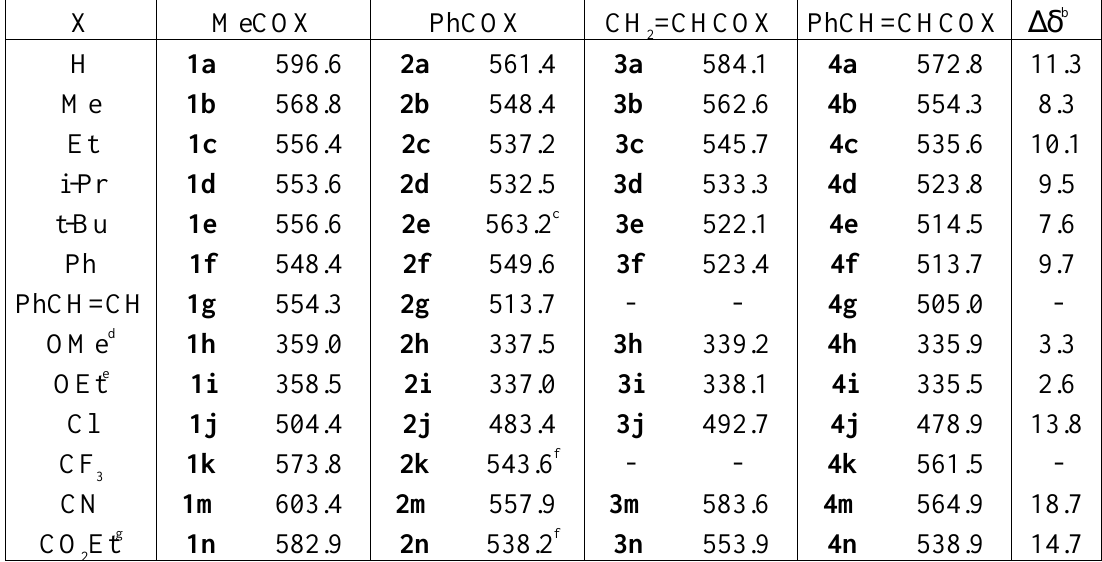
Table 1. 17 O NMR chemical shifts of 1 - 4 (solvent MeCN at 40°C) a .